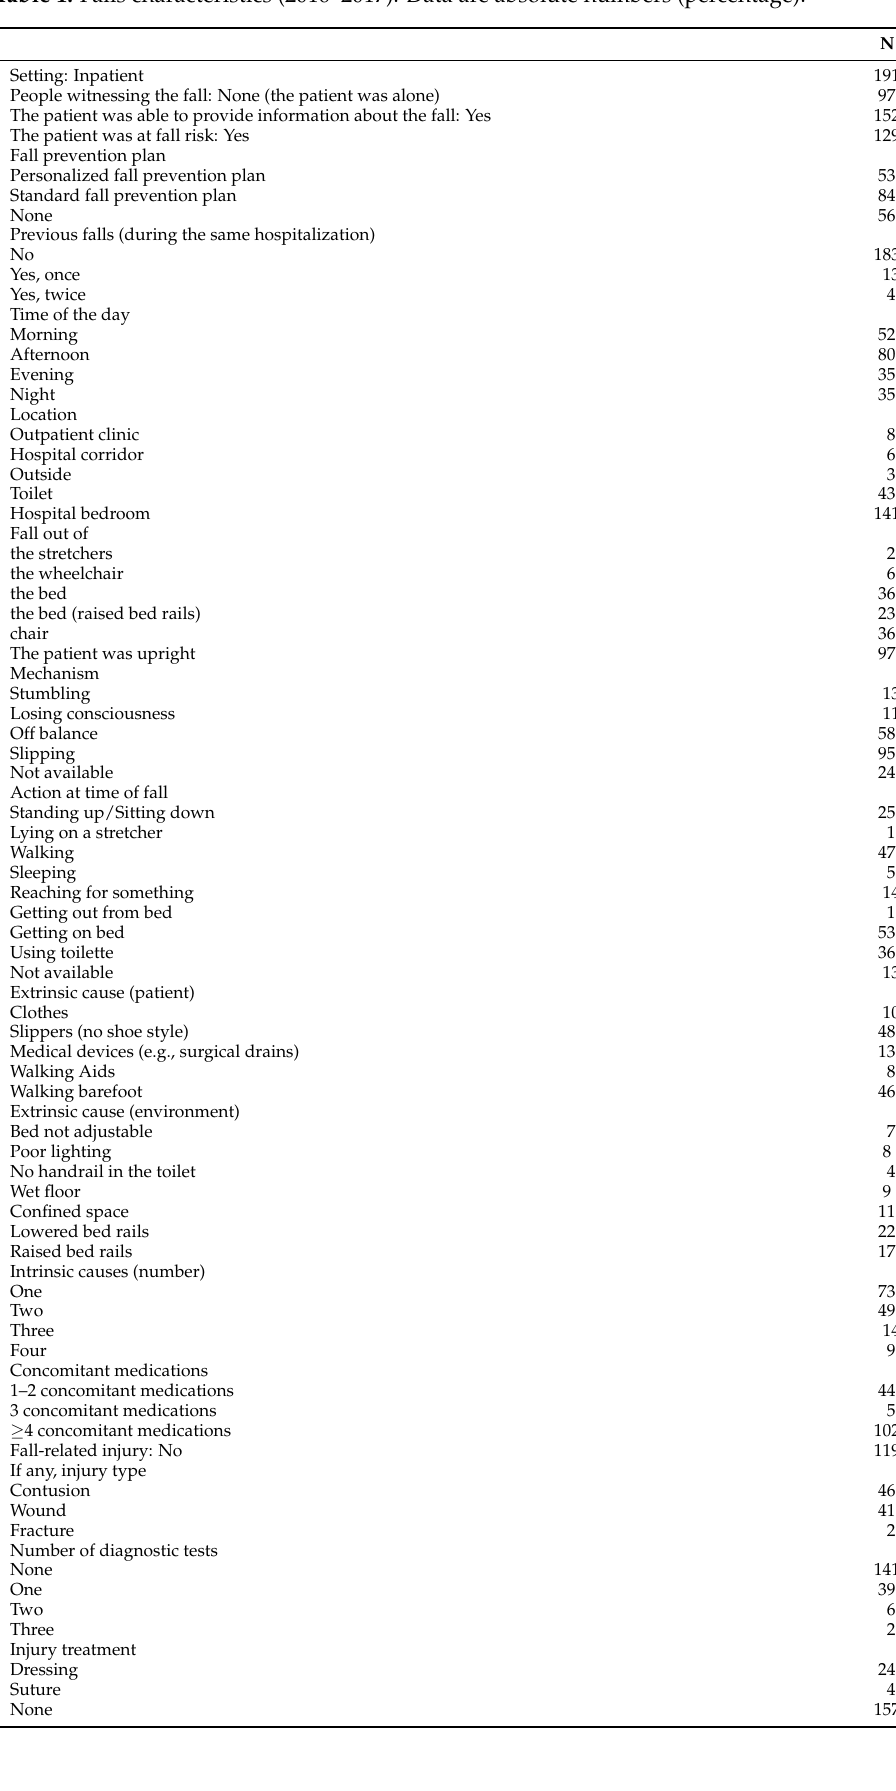
Table 1. Falls characteristics (2016–2017). Data are absolute numbers